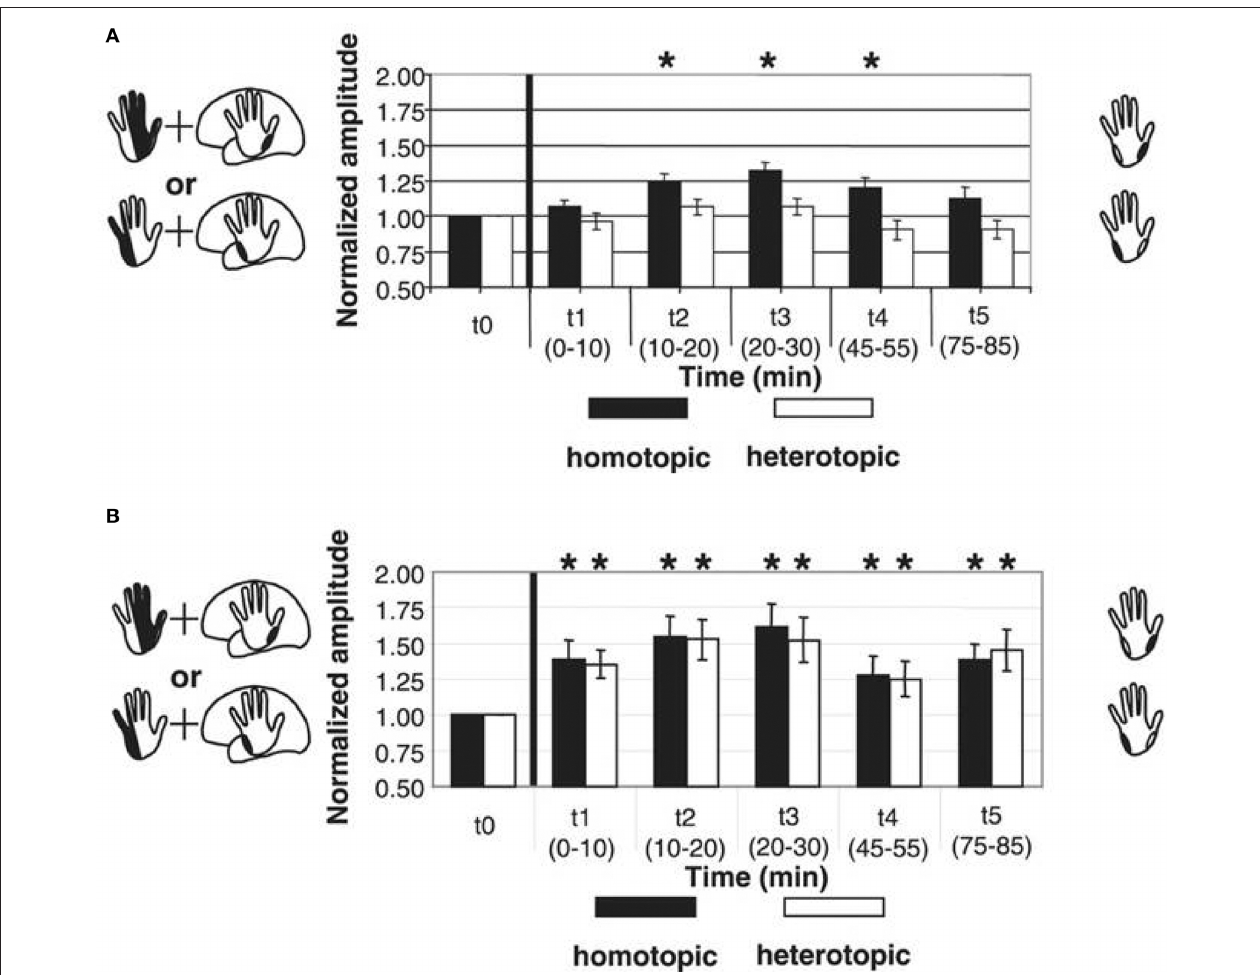
Figure 5 | Altered timing dependent LTP-like plasticity in human primary motor cortex (M1) in patients with writer’s cramp. PAS consisted of either electrical median nerve (MN) stimulation combined with TMS over the M. abductor pollicis brevis (APB) M1 representation [upper left scheme in (A) and (B) ] or ulnar nerve (UN) stimulation combined with TMS over the M. abductor digiti minimi (ADM) M1 representation [lower left scheme in (A) and (B) ]. PAS-induced changes in MEP amplitude were assessed from both muscles, which served as a homotopic target (black in the right schemes) stimulated by PAS (APB in MN-PAS, ADM in UN-PAS) or heterotopic target not stimulated by